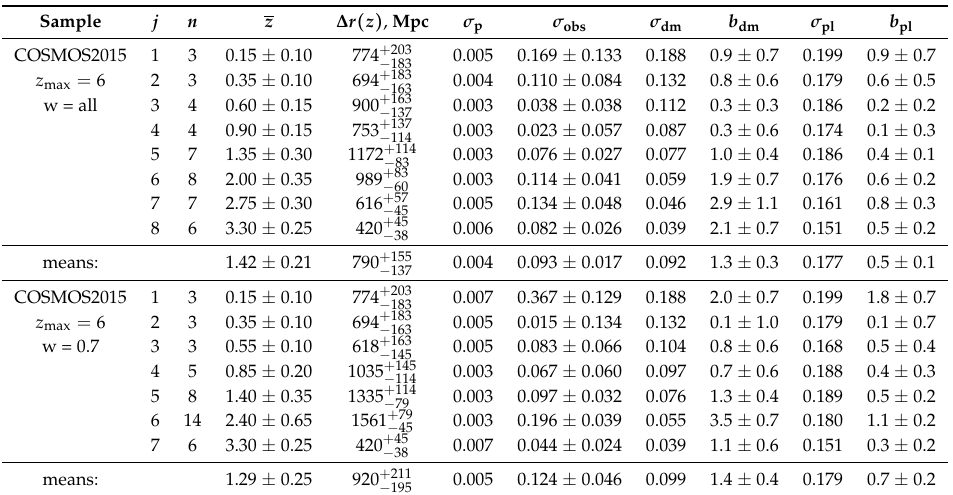
Table 3. Tables of structures for w -samples from the COSMOS2015 catalogue for a bin ∆ z = 0.1 with z max = 6 and the various σ z selection. The approximation is by theoretical formula (3). In the last string there are the means of corresponding values (by all structures): mean of redshifts z mean , mean of structure sizes in Mpc R mean , mean of Poisson noise level 1 σ P , mean of observed cosmic variance σ mean , mean of dark matter variance σ dm , mean of dark matter bias b dm , mean of Peebles correlation function variance σ pl and its bias b pl (see details in the